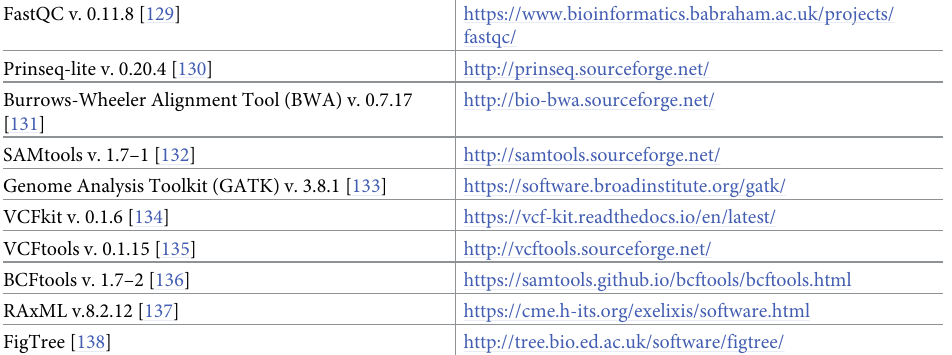
Table 1. Software summary